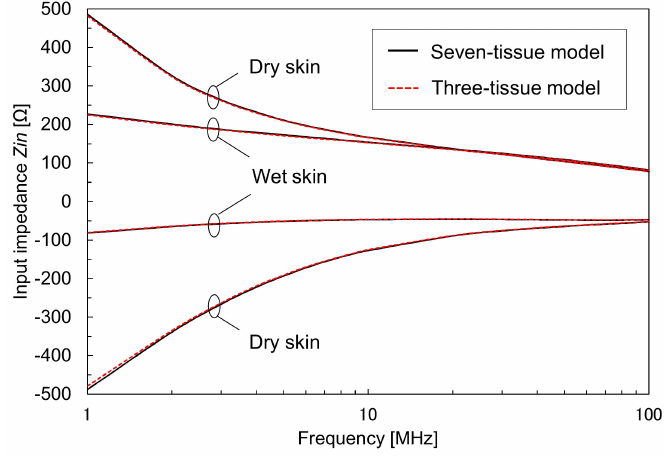
Figure 10. Input impedance characteristics of the wearable antenna calculated by using a seven-tissue model and a three-tissue model.